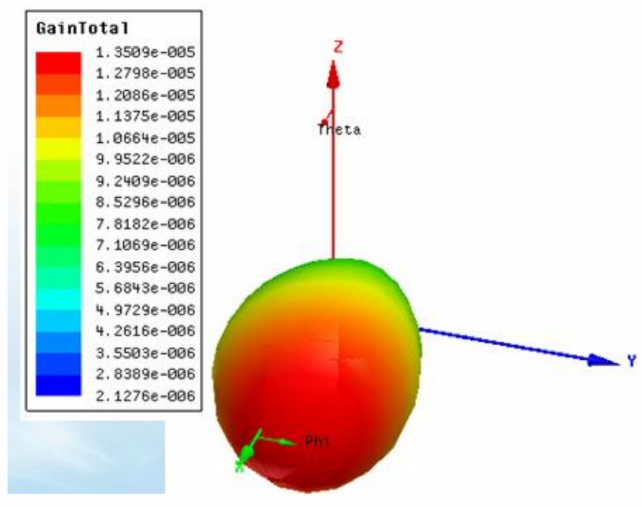
Figure 12. 3D magnetic field radiation energy map.